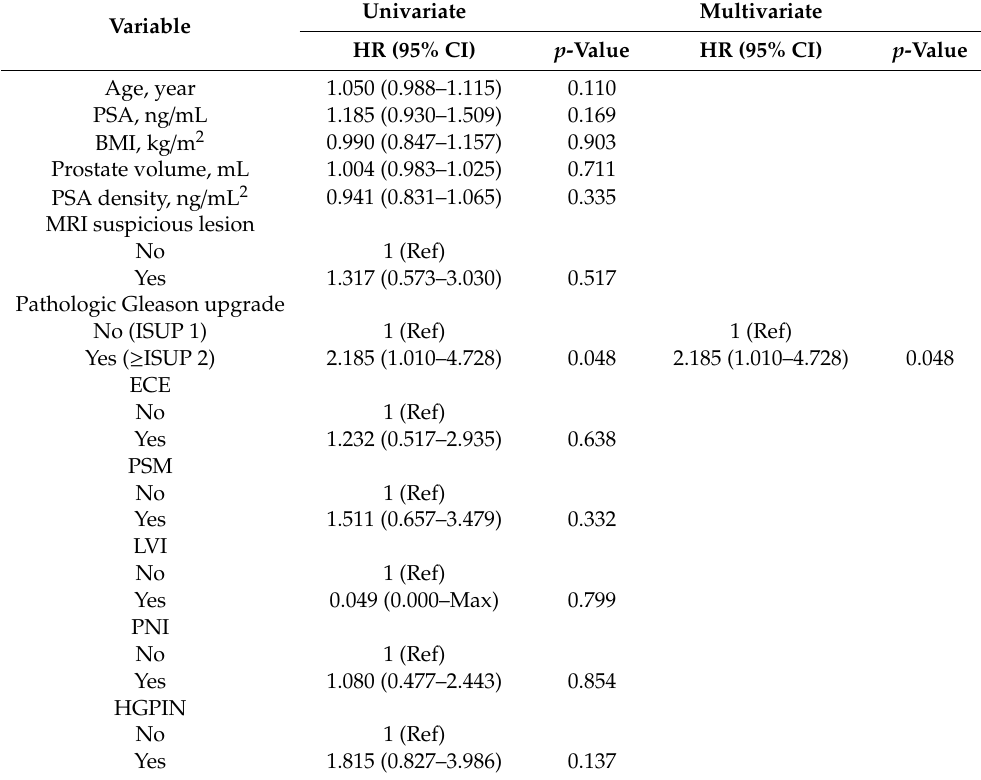
Table 2. Univariate and multivariate analyses of factors associated with biochemical recurrence.